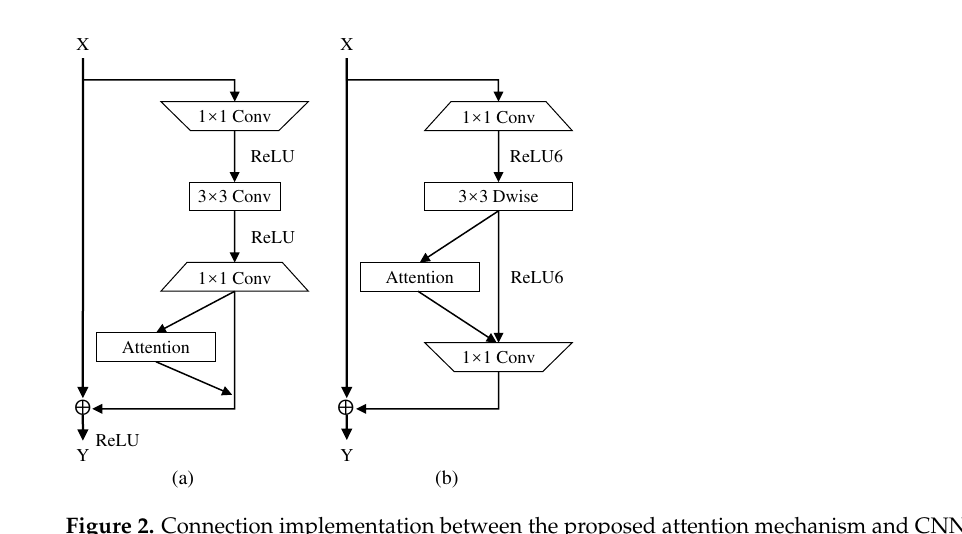
Figure 2. Connection implementation between the proposed attention mechanism and CNNs, where ⊕ denotes broadcast elementwise addition.